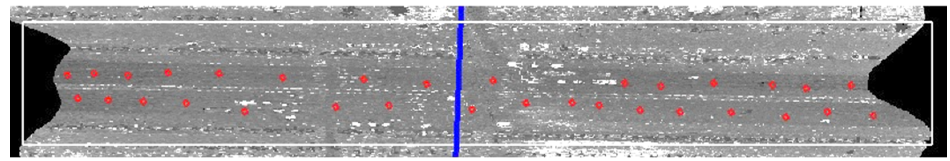
Figure 4. Sampling areas in flight strip 1.